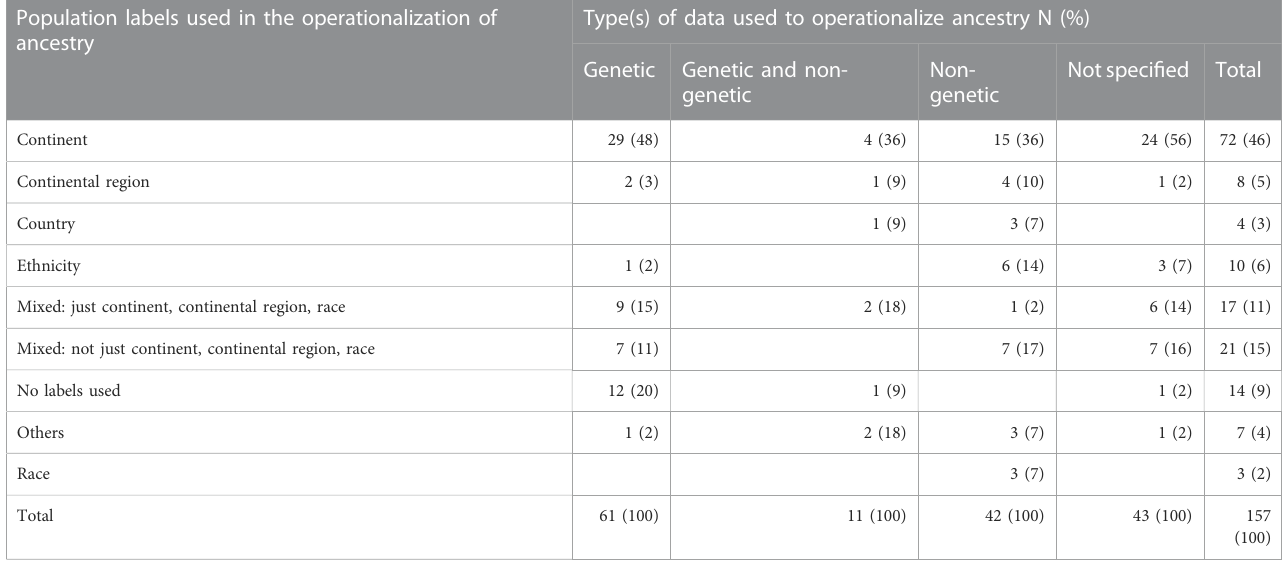
TABLE 5 Types of population labels employed by articles that use different types of data to operationalize ancestry. Because continental and continental region categoriesarethose geographicalcategoriesmostlikely tobecon fl atedwithracial categories, we separate out those articlesthat usedamixed setof labelsintothose that represented a mixture between these types of label (continent, continental region, and race) from other types of mixtures. Population labels used in the operationalization of ancestry